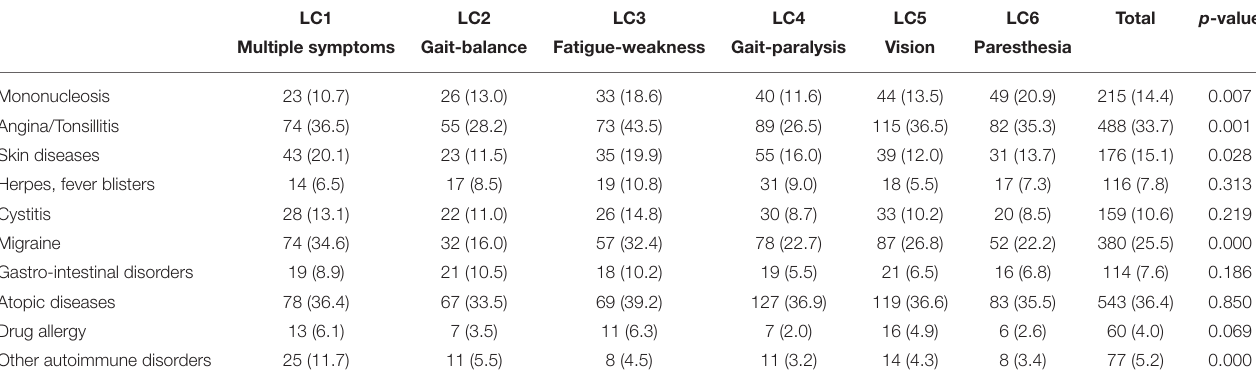
TABLE 3 | Latent classes based on MS onset symptoms: lifetime comorbidities; frequencies with column % (positive answers); p -values related to χ 2